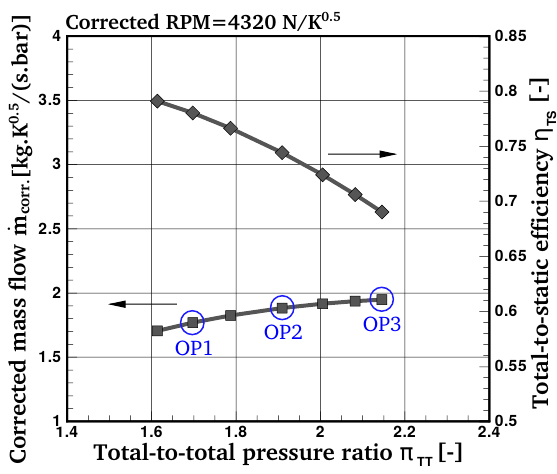
Figure 10. Performance map of the baseline turbine